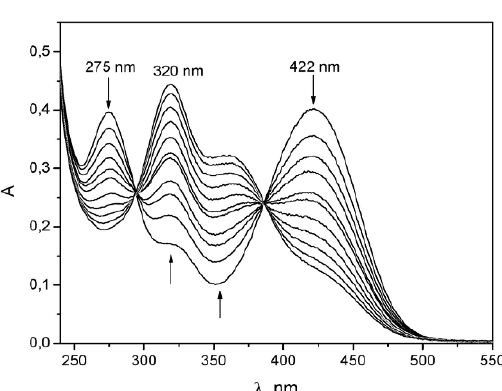
Figure 5. Kinetic traces observed at 550 nm after mixing 15 µM quercetin with 100 µM peroxynitrite at pH 5.0, 6.0 and 7.2.